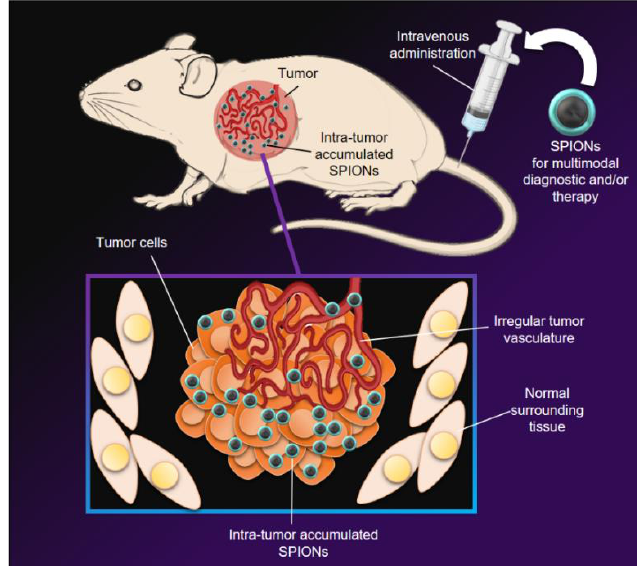
Figure 5. SPIONs intended for multimodal diagnostic and/or therapy are injected via IV. Subse- quently, SPIONs are subject to a certain time of blood circulation, and thanks to the discontinuous and irregular vasculature of the tumor, the nanoparticles accumulate in the tumor cells, thus being able to accomplish their objectives. This catchment of nanoparticles in the tumor cells is known as passive targeting and is favored by the enhancing permeability retention effect (EPR). This figure is original for this